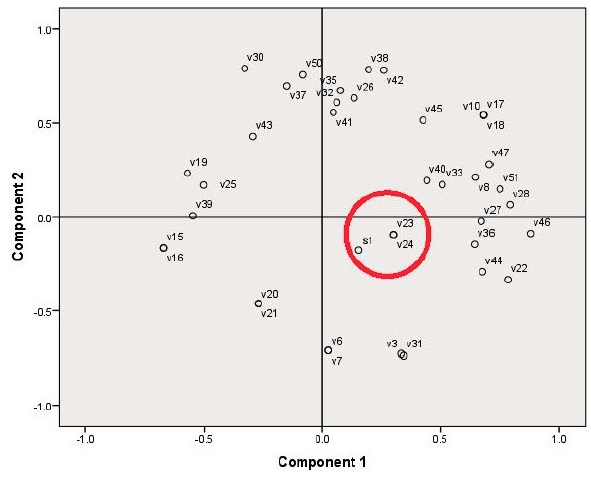
Figure 3. PCA on the rat glioma cell line proliferation inhibition and concentration of moss secondary metabolites (area marked with red circle: the glioma cell proliferation data (S1) and substance numbers (v1–v51) according to Table 5 were used as variables). In the case of human epidermoid carcinoma cells, no relations to specific substances and components were found. Differently from the correlation analysis, PCA (Figure 4) showed that the human lung carcinoma cells were possibly enclosed together with 4-hydroxybenzoic acid. Axes 1 and 2 significantly explain 52% of the variation.